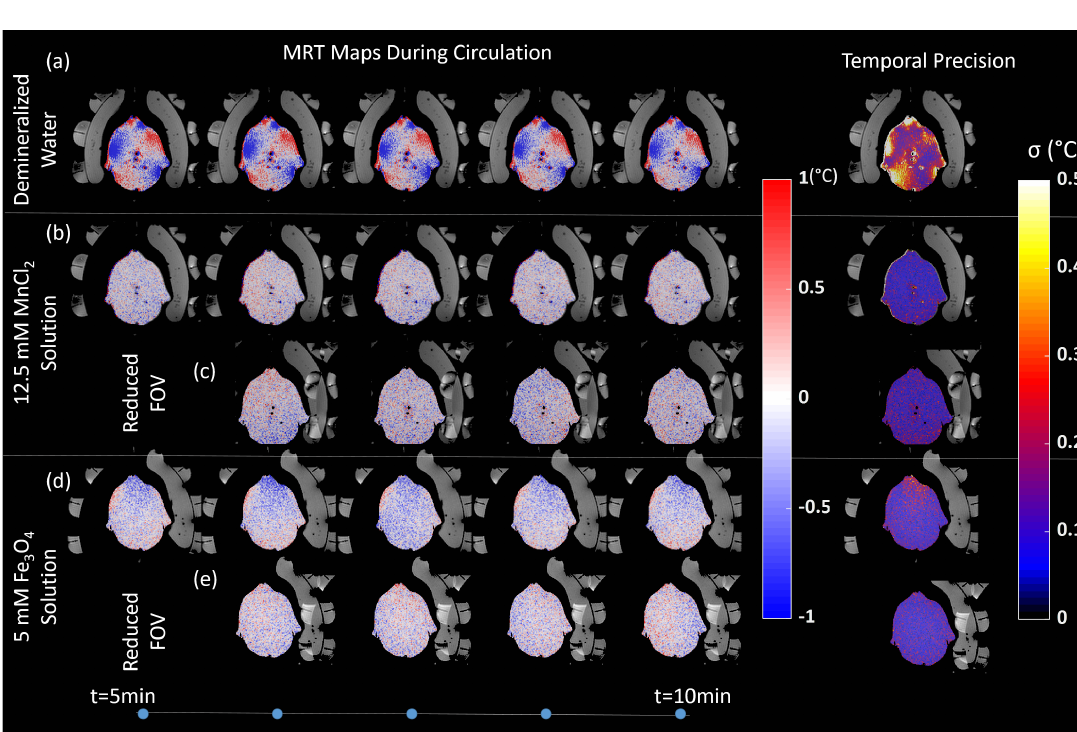
Figure 4. MRT maps and temporal precision map during the water circulation when the applicator right side WB (left in the image) was filled with (first row ( a )) demineralized water; (second ( b ) & third row ( c )) 12.5 mM MnCl 2 solution full and reduced Field of View, respectively; (fourth ( d ) &fifth ( e ) row) 5 mM Fe 3 O 4 solution full and reduced Field of View, respectively. In the last column, MRT precision per voxel during the water circulation is shown. The expected measured temperature change both temporally and spatially was 0 ◦ C. Using this assumption, MRT precision was calculated by calculating the standard deviation over all PRFS temperature measurements. Note that the applicator left side WB (right in the image) was always filled with demineralized water for